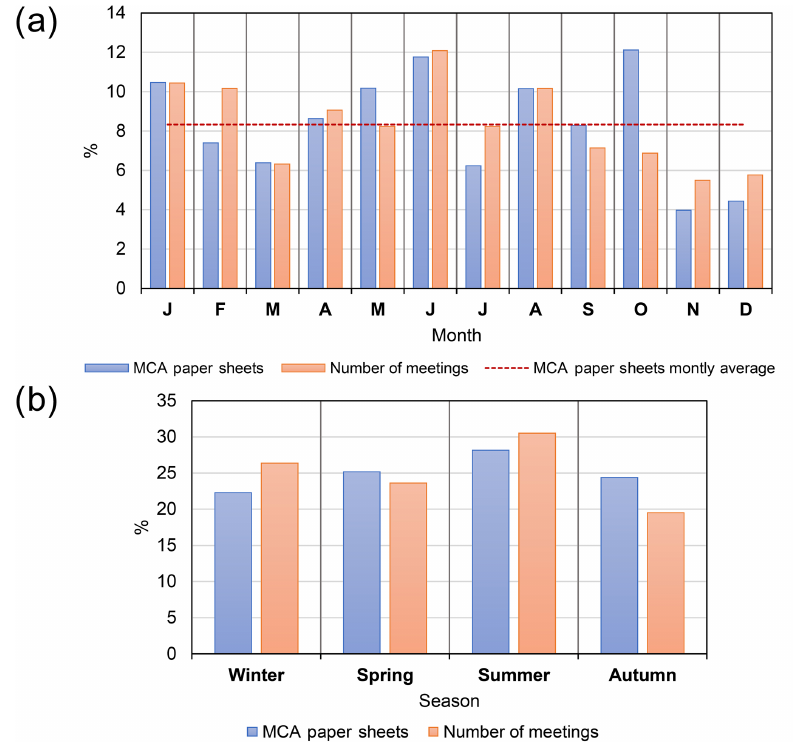
Figure A3. Amount of MCA paper sheets used by month (a) and season (b) in Caravaca. The values are the averages for the years 1698, 1614, 1657, 1749, 1800, 1850 and